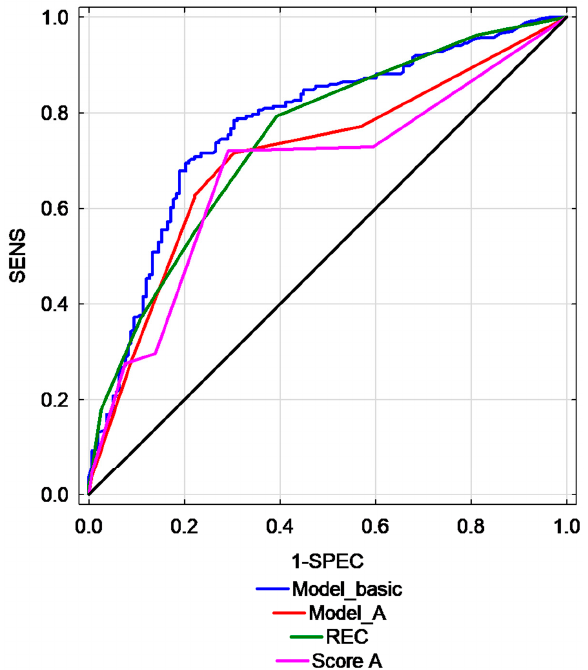
Figure 3. Comparison of ROC curves for different studied predictive models. (Risk of Endometrial Cancer scoring model—REC, sensitivity—SENS, specificity—SPEC, Model basic, Model A, Score A–various models).